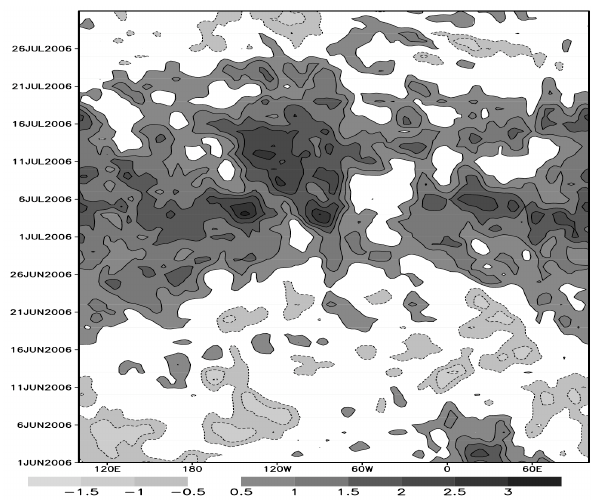
Figure 16. Time-longitude diagram of 300 hPa temperature anomalies (°C) averaged over 10°S-20°N relative to 1979-1999.